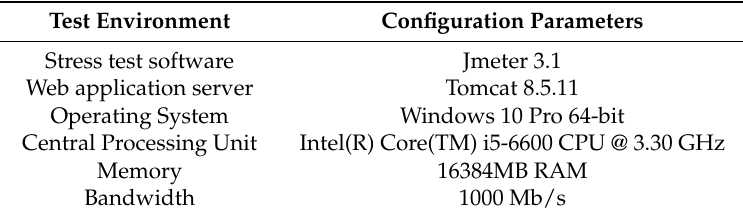
Table 5. System test environment.